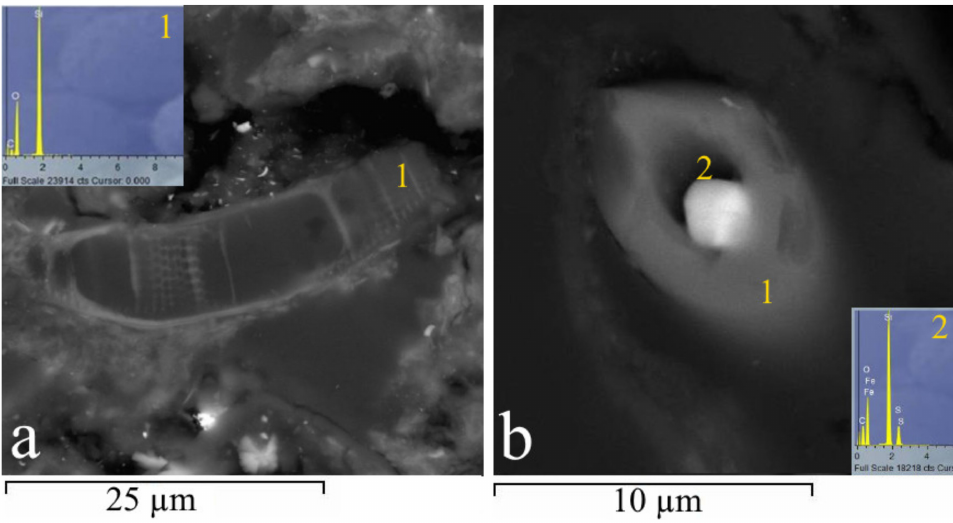
Figure 9. Microphotographs of the mortmass of biota of the sapropel sediments ( a , b ) and the their quantitative chemical analysis (1, 2): ( a ) the shells of siliceous, 1—(mSiO 2 · nH 2 O); ( b ) 1—the remains of macrophytes, 1—(mSiO 2 · nH 2 O), 2—pyrite individual